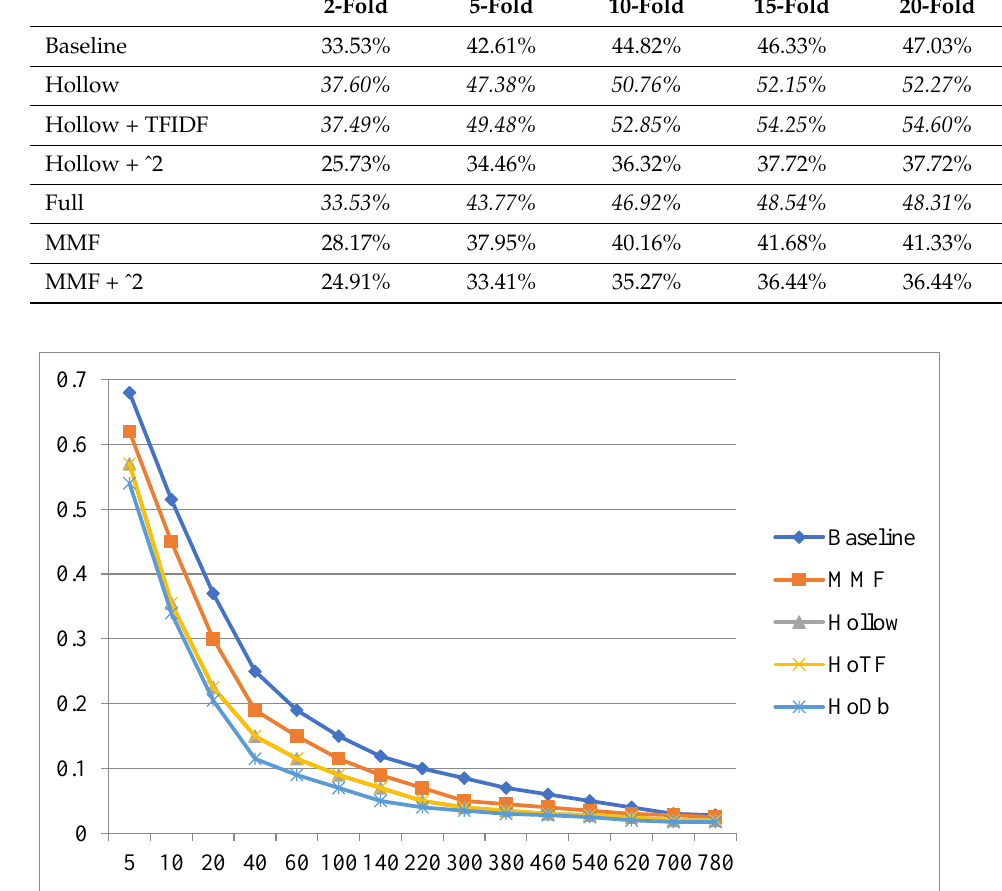
Table 1. Classification accuracy of each feature representation method.